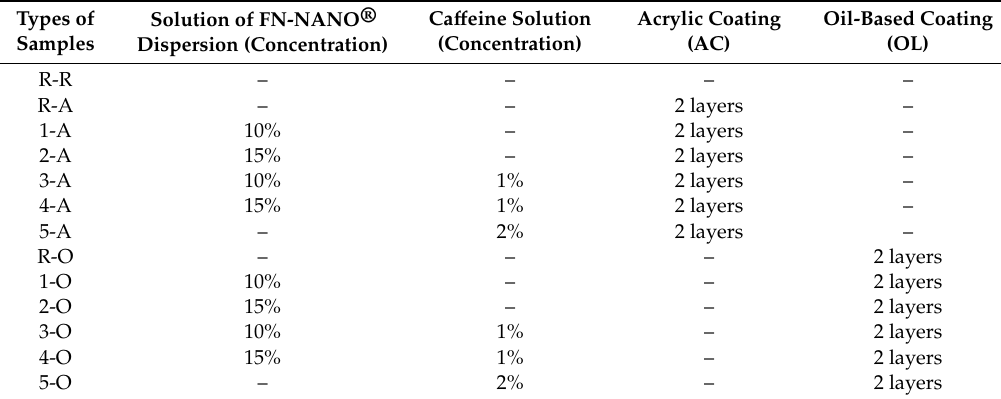
Table 1. Tested sets of specimens and their